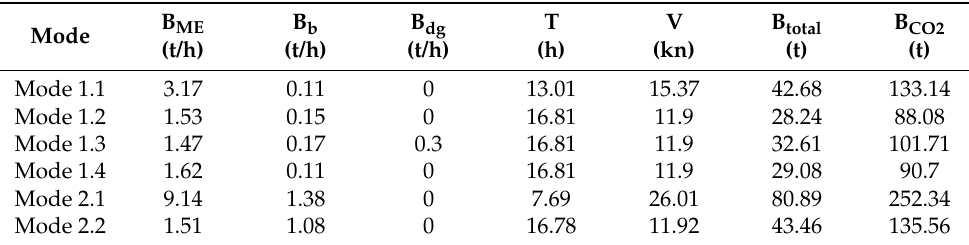
Table 3. Fuel oil consumptions and CO 2 emissions